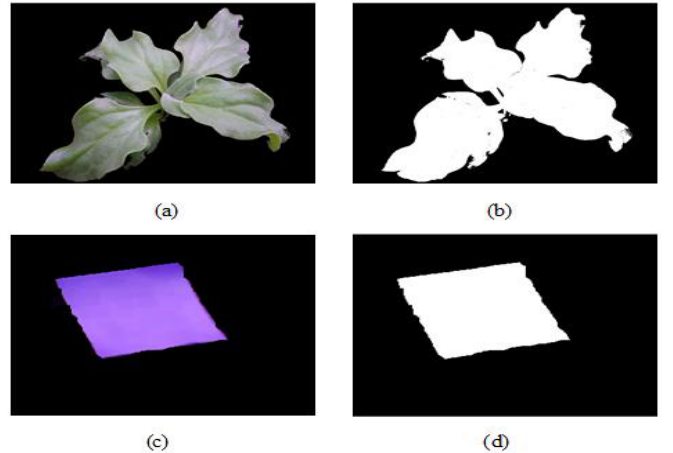
Figure 4. Segmented image of the ice plant canopy ( a ), inverted binary ice plant canopy image ( b ), segmented reference image ( c ), inverted binary reference image ( d ).